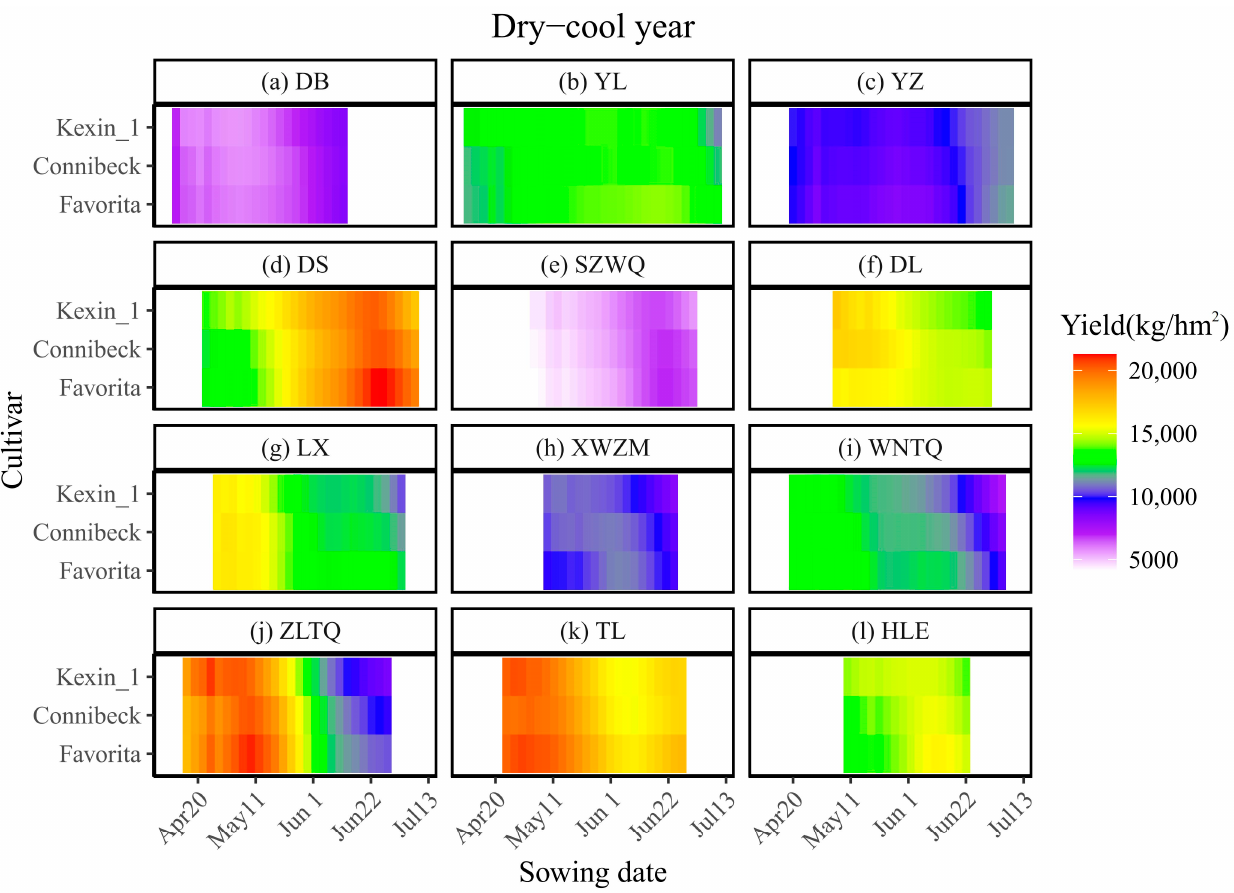
Figure 4. Yield variations across the APE of North China with regard to cultivars and planting dates in dry-cool years. Different horizontal bands represent different cultivars. ( a – l ) refers to different meteorological stations in the APE of North China.